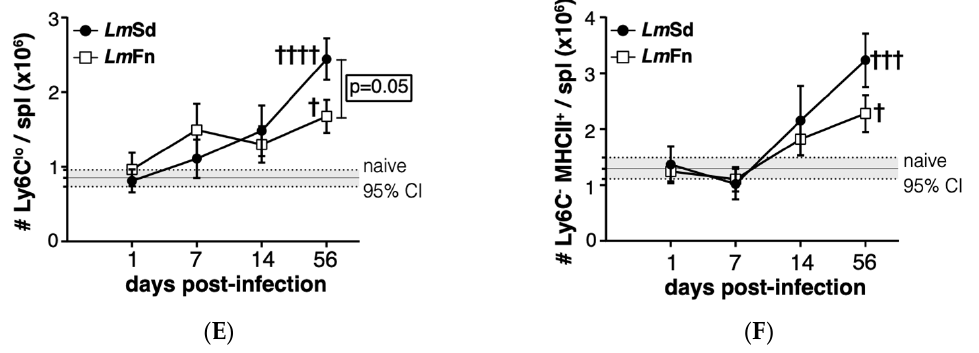
Figure 3. Induction of myeloid-biased multipotent progenitors is associated with an accumulation of myeloid cells during persistent infection with L. major . The number of cells within the CD48 + CD150 − CD135 − MPP3 subset of hematopoietic progenitor cells in ( A ) bone marrow and ( B ) spleen at different times post-infection. The number of ( C ) Ly6G + granulocytes; ( D ) Ly6C hi Ly6G − inflammatory monocytes; ( E ) Ly6C Lo Ly6G − alternative monocytes; and ( F ) Ly6C − Ly6G − MHCII + monocyte-derived myeloid cells in the spleen. Graphs represent compiled results (mean ± SEM) from at least 4 independent experiments for each time point, with n = 13, n = 11, n = 11, and n = 15 mice per group ( Lm Fn vs. Lm Sd) at 1-, 7-, 14-, and 56-days post-infection, respectively. The grey horizontal line and shaded area represent mean ± 95% confidence interval for naïve control mice ( n = 16). * p < 0.05 comparing infection with Lm Fn vs. Lm Sd at a given time point and †, ††, †††, †††† p < 0.05 comparing infected groups ( Lm Fn or Lm Sd) to naïve control mice. See also Supplementary Figures S2 and S3 for flow cytometry gating strategies and representative